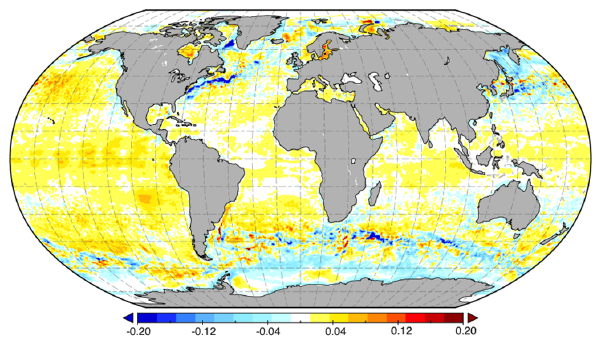
Figure 8. Map of differences of SST Root Mean Square error between C-GLORSv4 and C-GLORSv5. The RMSE is computed against NOAA SST 1 / 4 daily analyses (Reynolds et al., 2007). Pos- itive (negative) differences indicate that C-GLORSv5 outperforms (underperforms) C-GLORSv4. Units are degrees